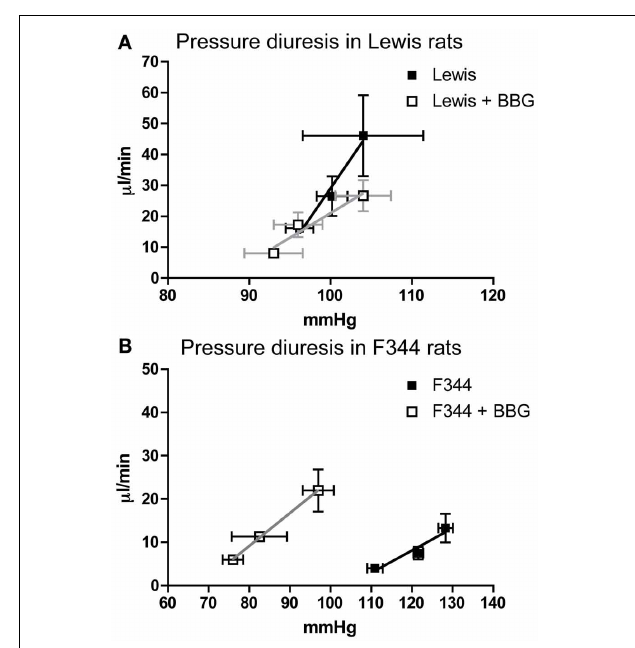
FIGURE 6 | The Pressure diuresis relationship measured in (A) Lewis and (B) F344 rats receiving either saline (closed symbols) or Brilliant Blue G (open symbols) by intravenous infusion. Data are mean ± SE . Statistical test was performed by linear regression analysis. 1000-fold greater. BBG has been used previously in vivo to elu- cidate P2X 7 receptor functionality (Jiang et al., 2000; Peng et al., 2009). Indeed, chronic administration of BBG reduces